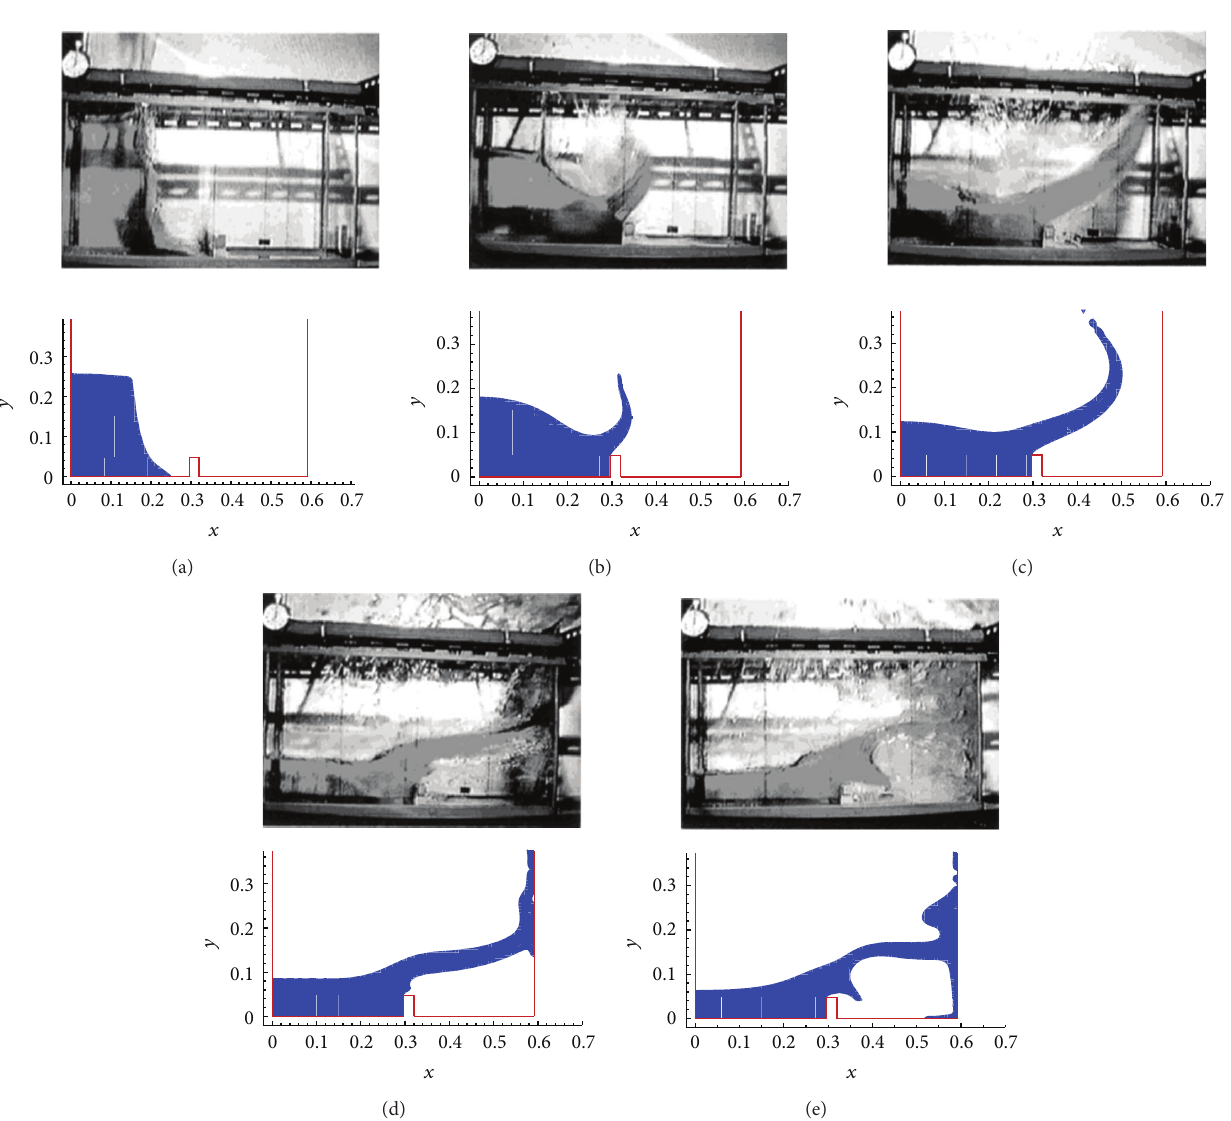
Figure 9: Comparison of interface evolution at time 𝑡 = 0.1 s (a), 𝑡 = 0.2 s (b), 𝑡 = 0.3 s (c), 𝑡 = 0.4 s (d), and 𝑡 = 0.5 s